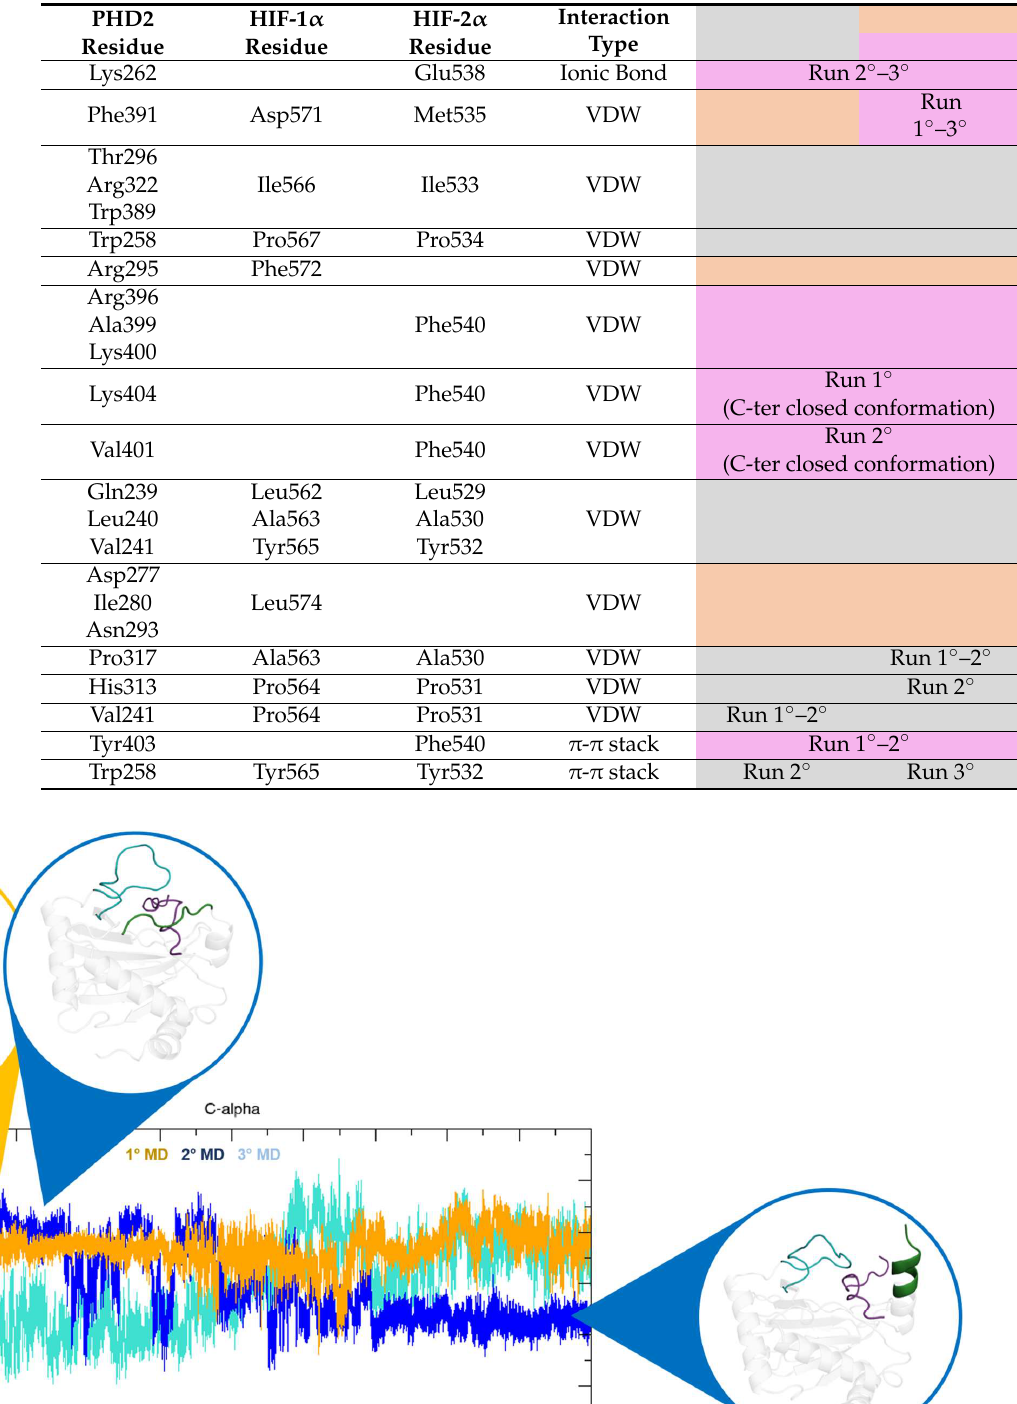
Figure 4. PHD2 C-terminus conformations. The C-terminus interacts with HIF-2 α during the entire first run (orange), and in the second run (blue) between 100 and 250 ns. Further, the C-terminus appears to assume a mainly alpha secondary structure during the last 300 ns of the second run